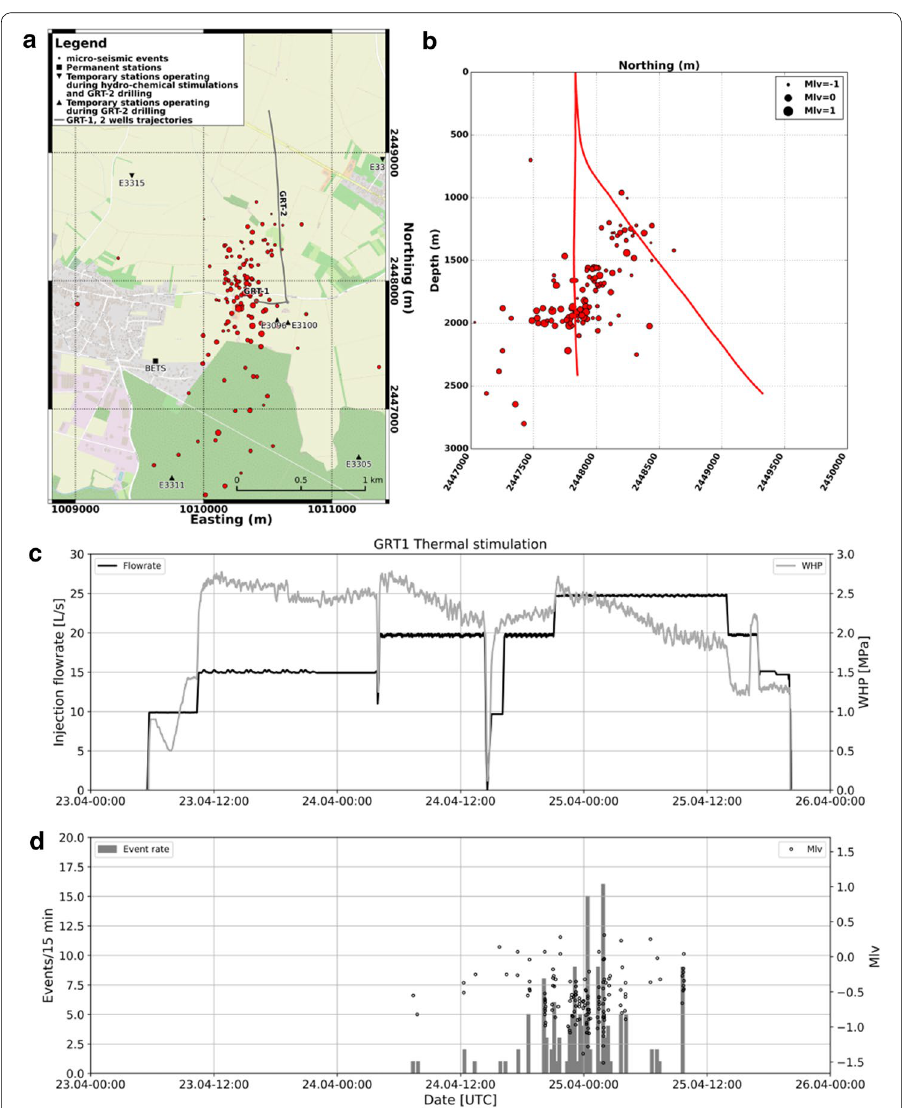
Fig. 8 GRT-1 thermal stimulation: epicenter map ( a ) and South–North vertical projection ( b ) of the seismicity recorded (red circles); injection flow rate and wellhead pressure over time ( c ) in parallel with the seismic rate per 15 min and the local magnitude ( d